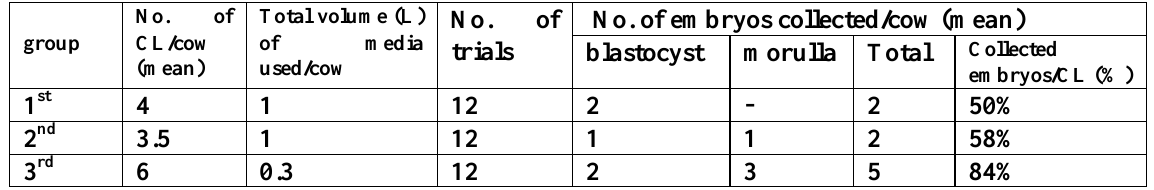
Table (1): Number of corpora lutea, and the number of embryos collected by foley catheter fixed at different sites in the cervix of